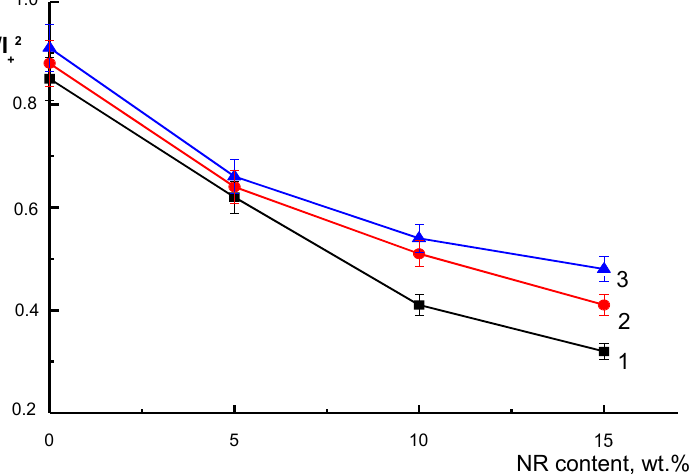
Figure 7. I +1 /I − 2 value in PLA/NR fibers of initial (1) and after 60 days (2) and 220 (3) of soil exposure. In the original samples, with an increase in the NR content, the I + /I − ratio